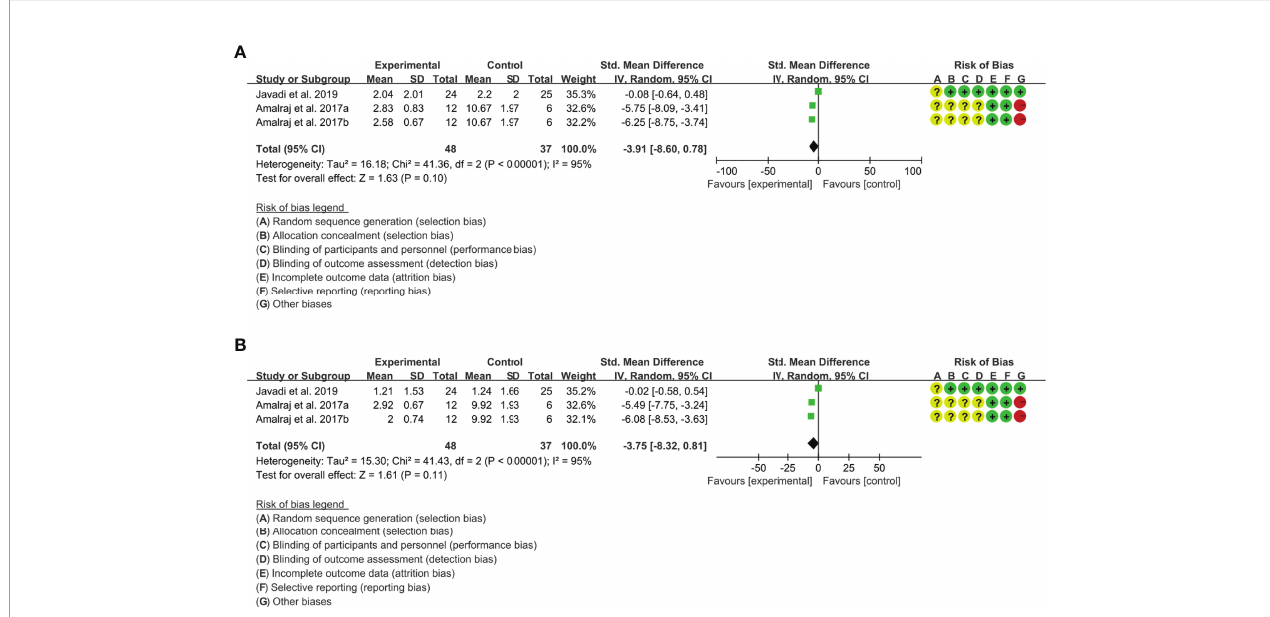
FIGURE 4 | (A) Tender joint count; (B) Swollen joint